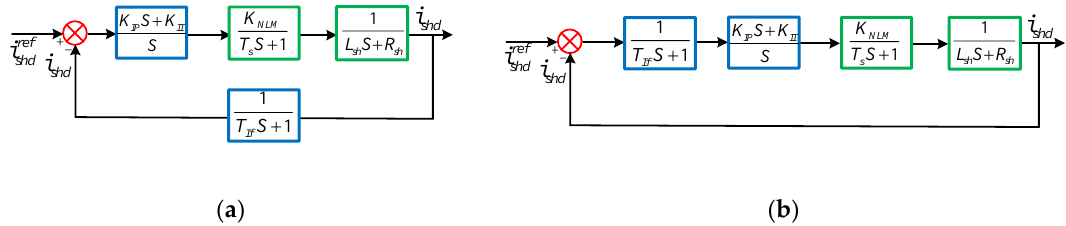
Figure 11. The current control loop of the shunt converter. ( a ) The initial current control loop; ( b ) The simplified unity-feedback current control loop.